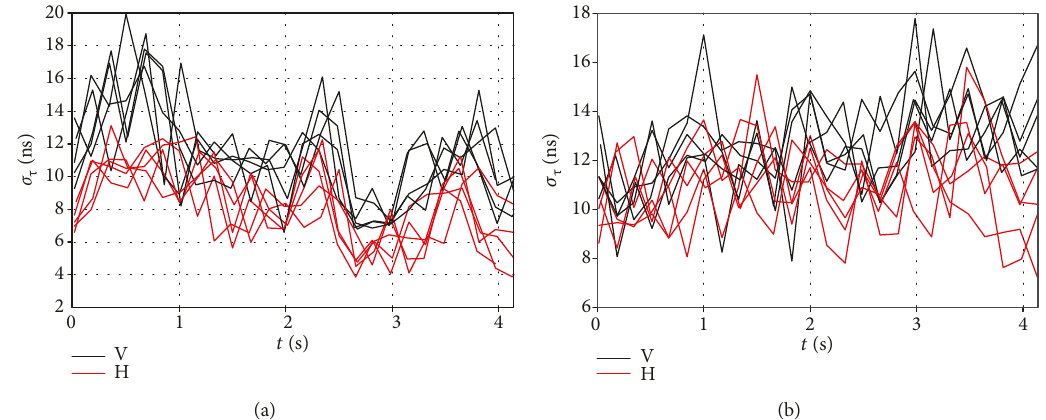
t ), for the V- and H-polarized on-body antenna placed on TO τ ) vs. time (